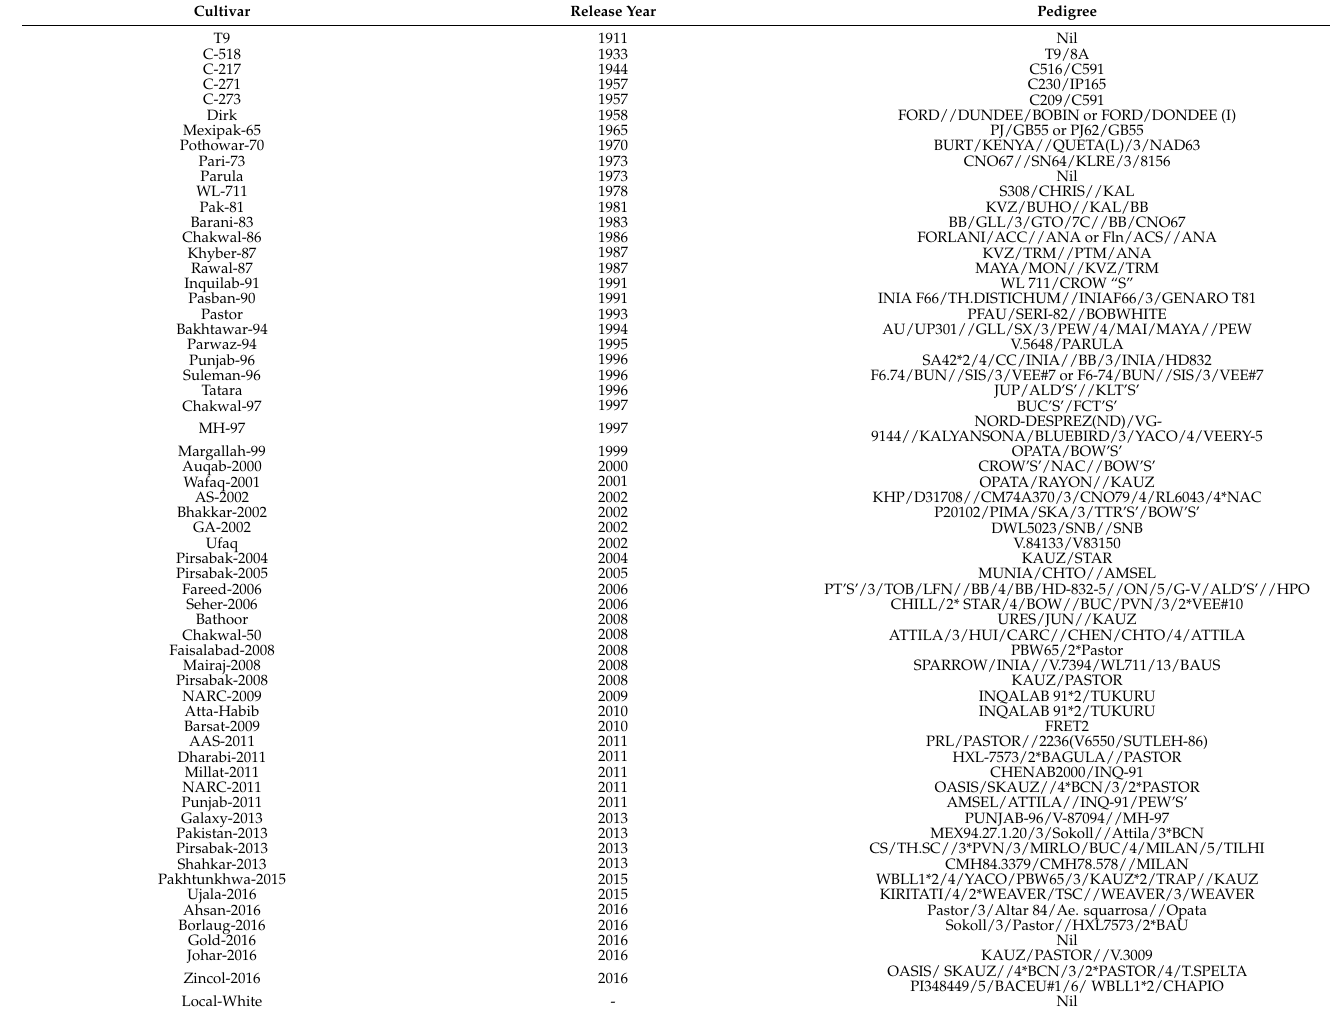
a randomized complete block design (RCBD) with two replications. The NARC site is located at 33 ◦ 43 (cid:48) N 73 ◦ 04 (cid:48) E. The date of sowing was 5 December in 2018 and 8 December in 2019. Table 1. Pedigree of historical wheat cultivars evaluated for phenological parameters along with the grain iron and zinc